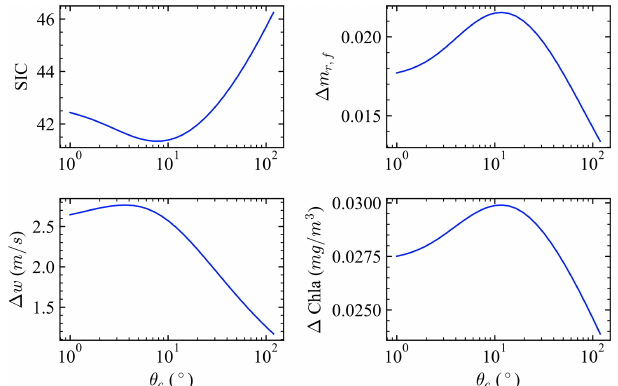
Figure B2. The Shannon information content (SIC) and corre- sponding theoretical retrieval uncertainties for refractive index ( m r , f ), wind speed ( w ) and Chl a with respect to various corre- lation angles. The results are for one example case with Chl a = 0 . 1mgm − 3 , w = 3 . 0ms − 1 , m r , f = 1 . 55 and AOD (550nm) = 0 .